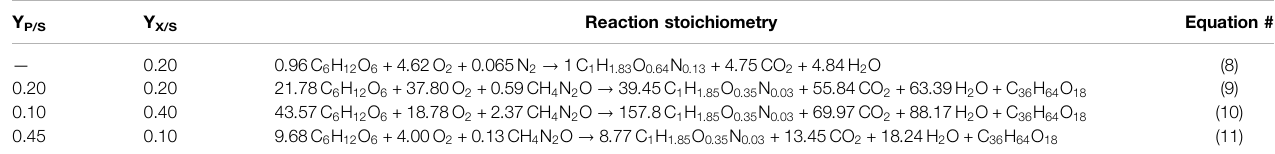
TABLE 3 | Reaction stoichiometry for the seed culture (8) and potential CL fermentations with different yields Y P/S and Y X/S (9 – 11). Y P/S Y X/S Reaction stoichiometry Equation